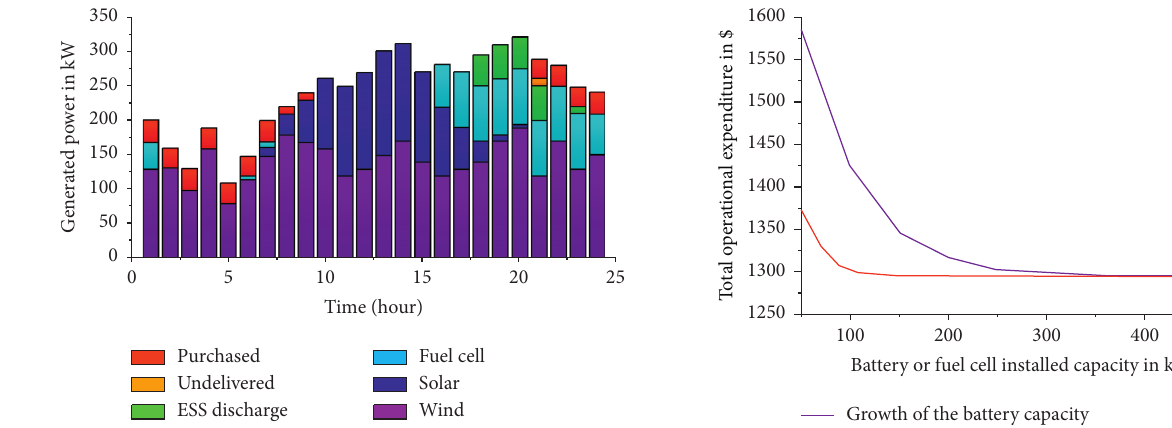
Figure 10: Optimum scheduling for various power sources and purchased power from the power market regardless of the fixed subsidies.